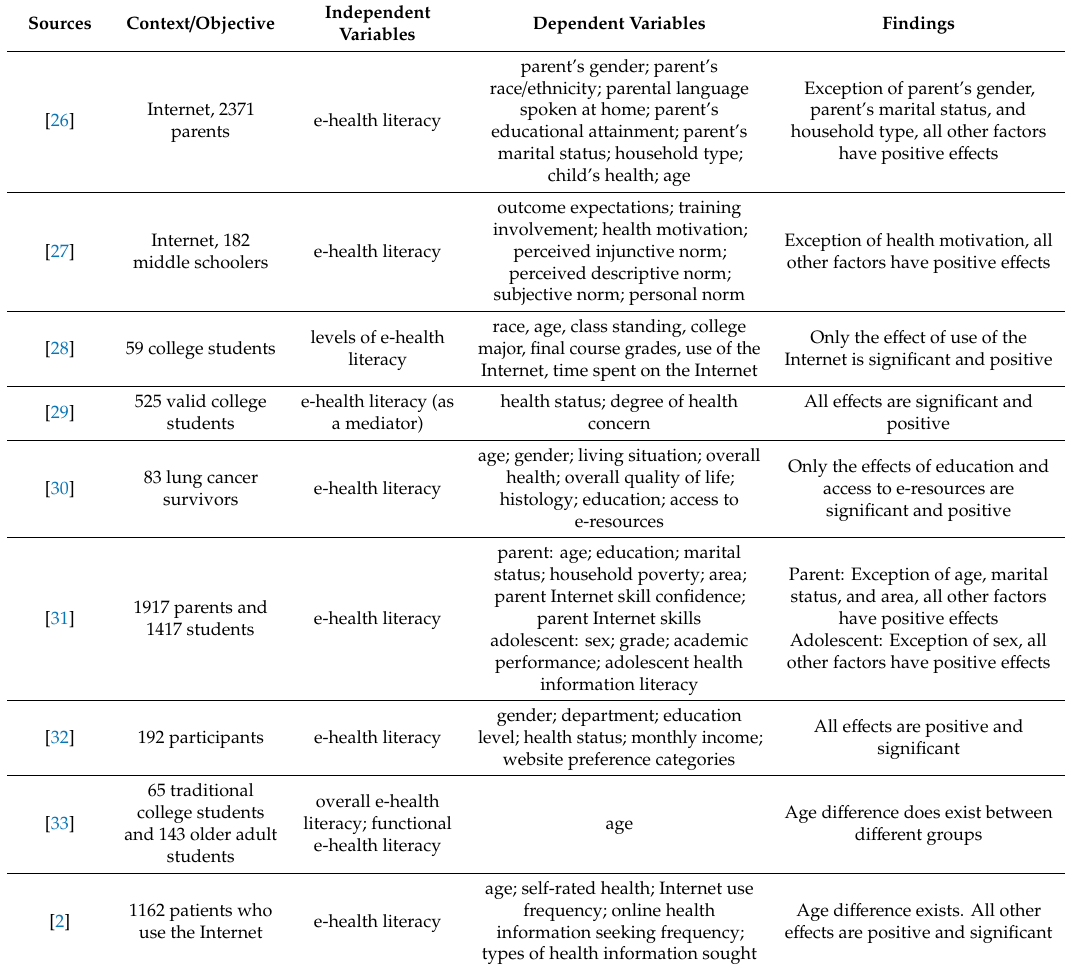
Table 1. A summary of prior studies on e-health